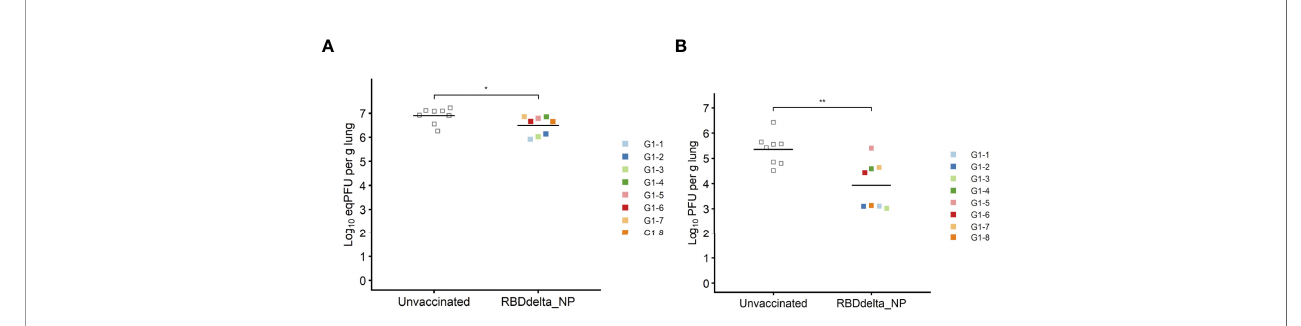
FIGURE 8 | Protection against lung infection at 3 dpi: On day 3 post-infection K18-hACE2 transgenic mice were sacri fi ced and lungs were collected to assess viral titers. Immunized Group 1 (n= 8) is with individual color code and unvaccinated Group 2 (n= 8) is in grey. (A) Viral load in lungs expressed in eqPFU per gram of lung